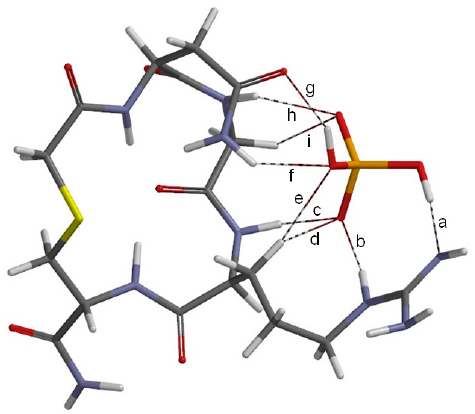
Figure 4. The nine-point interaction (interactions a–i) in RC (the reactant complex shown in Figure 3). The corresponding interatomic distances are shown in Table 1. Grey: carbon; white: hydrogen; blue: nitrogen; red: oxygen; orange: phosphorus; yellow: sulfur. Table 1. Interatomic distances (Å) in RC (Figure 3), TS1 (transition state of the first step) (Figure 5), and TH1 (tetrahedral intermediate directly connected to TS1) (Figure 6) corresponding to the interactions a–i shown in Figure 4.